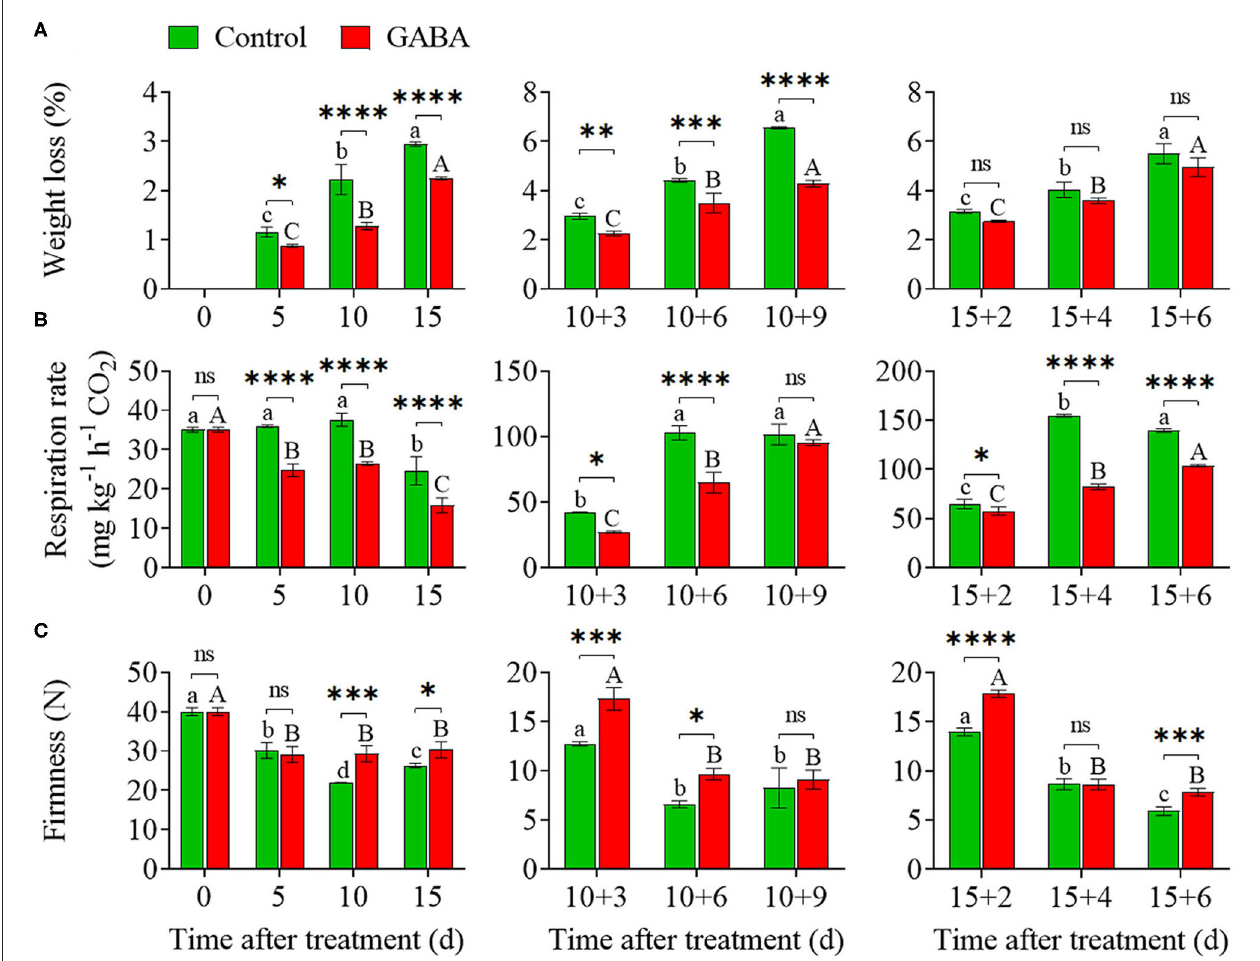
FIGURE 2 | The weight loss (A) , respiration rate (B) , and firmness (C) of carambola fruit during storage at 4 and 25 ◦ C. Error bars are expressed as means ± SD (standard deviation) of three replicates ( n = 3). The asterisks indicate statistically significant differences between treatments at * p < 0.05, ** p < 0.01, *** p < 0.001, **** p < 0.0001, ns, not